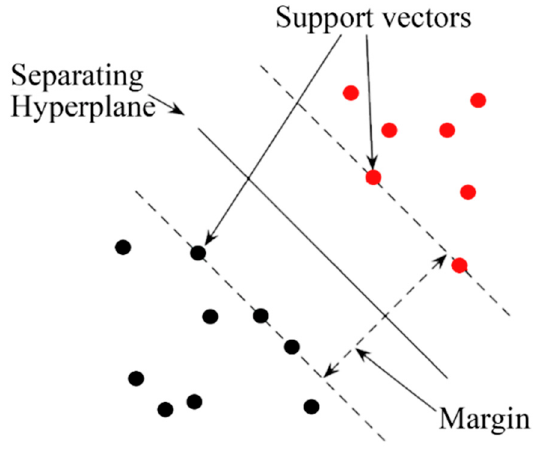
Figure 1. The algorithm of support vector machines.